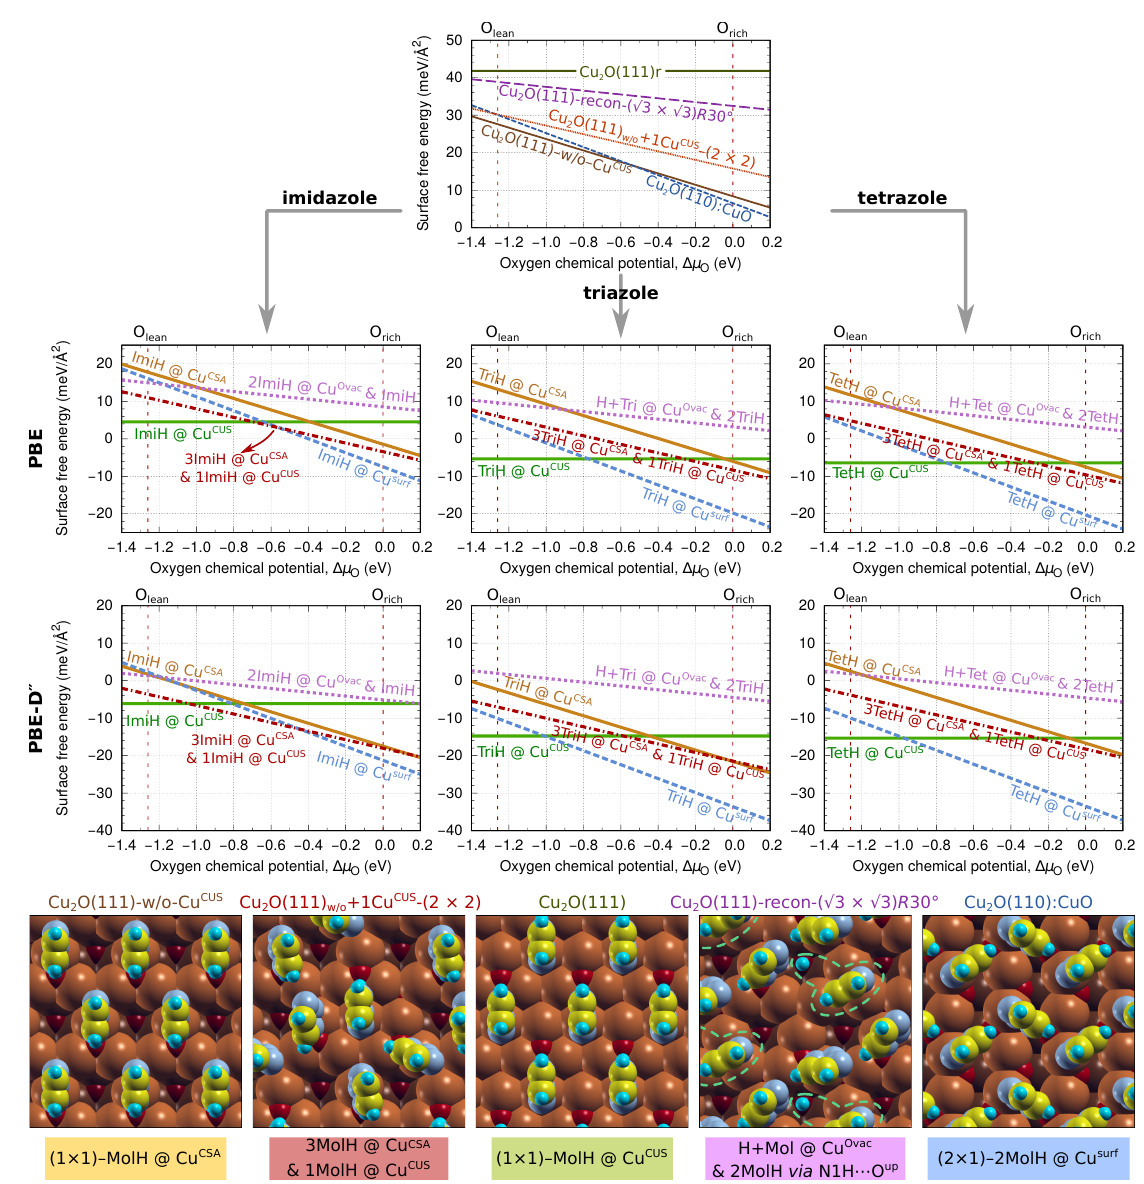
Figure 6. Surface free energies ( top row) as a function of oxygen chemical potential, γ surf ( µ O ), for five considered surfaces and their stabilization (two middle rows) due to high coverage r 100% adsorption, γ surf ( µ O ) + n ε ads / A , of imidazole ( left) , triazole ( middle ), and tetrazole ( right ) as calculated with PBE and PBE-D (cid:48)(cid:48) functionals; note that ordinate axes are different for each row but within the row they are the same. The bottom row shows top-view snapshots of high coverage triazole structures on the five considered surfaces; surface Cu atoms are shown as bigger brown balls and O atoms as smaller red balls, whereas molecular atoms are colored as in Scheme 1. Notice the mixed-site and mixed-mode adsorption on √ √ Cu 2 O(111) w/o +1Cu CUS –(2 × 2) and Cu 2 O(111)-recon-( 3 × 3) R 30 ◦ , respectively. In particular, on the former one molecule adsorbs at Cu CUS and three molecules at Cu CSA sites per supercell, whereas on the latter one molecule adsorbs dissociatively and two molecules non-dissociatively (labeled as H+Mol & 2MolH); dissociated molecules are